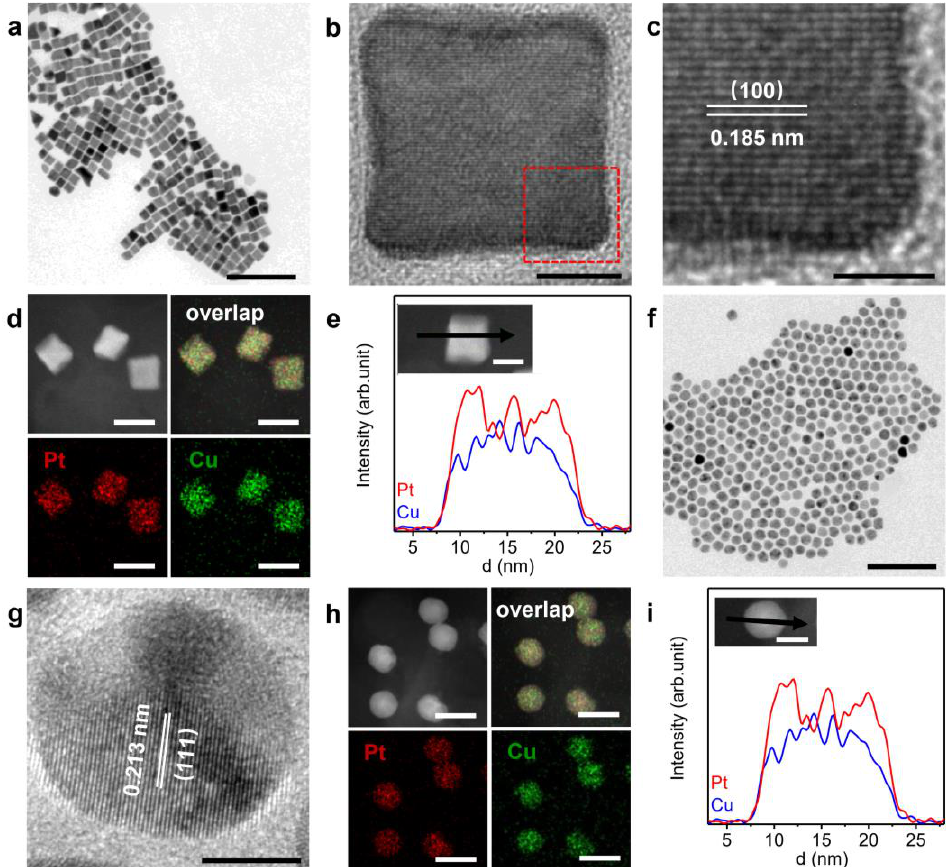
Figure 2. Morphological and structural characterizations of PtCu NCs and PtCu NPs. ( a ) TEM image of the PtCu NCs. ( b ) HRTEM image of a PtCu NC. ( c ) The local enlarged region in the colored frame of ( b ). ( d ) HAADF-STEM image and the corresponding elemental mapping of PtCu NCs. ( e ) Line- scanning profile of a PtCu NC. ( f ) TEM image of the PtCu NPs. ( g ) HRTEM image of a PtCu NP. ( h ) HAADF-STEM image and the corresponding elemental mapping of PtCu NPs. ( i ) Line-scanning profile of a PtCu NP. Scale bars: ( a , f ) 100 nm, ( b , g ) 5 nm, ( c ) 2 nm, ( d , h ) 20 nm, ( e , i , inset) 10 nm. PtCu NPs were obtained by decreasing the amount of CTAB in the synthesis